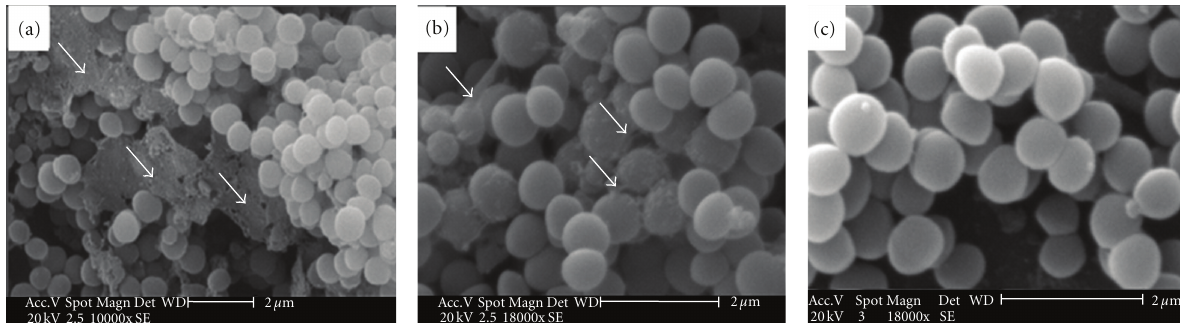
Figure 6: A scanning electron micrograph revealing variable degrees of heavy biofilm layer production. Highly and strongly adherent isolates produced a large thick layer (a), and moderately and weakly adherent isolates formed a lower degree of a close network among themselves (b), while negative biofilm producers showed an absence of network layers